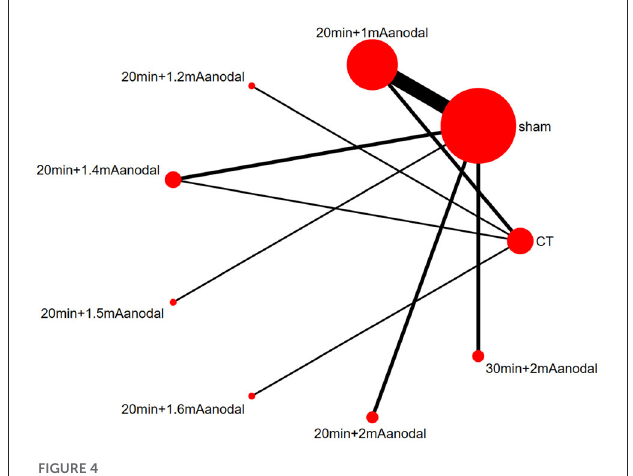
FIGURE4 Network diagram.